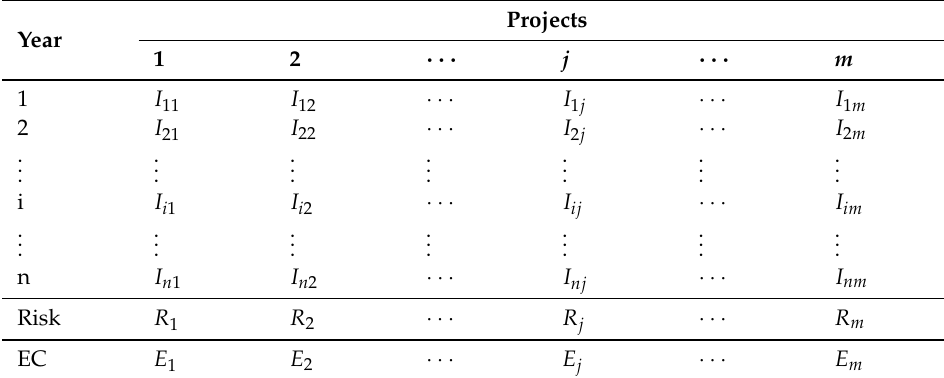
Table 1. Description of investment